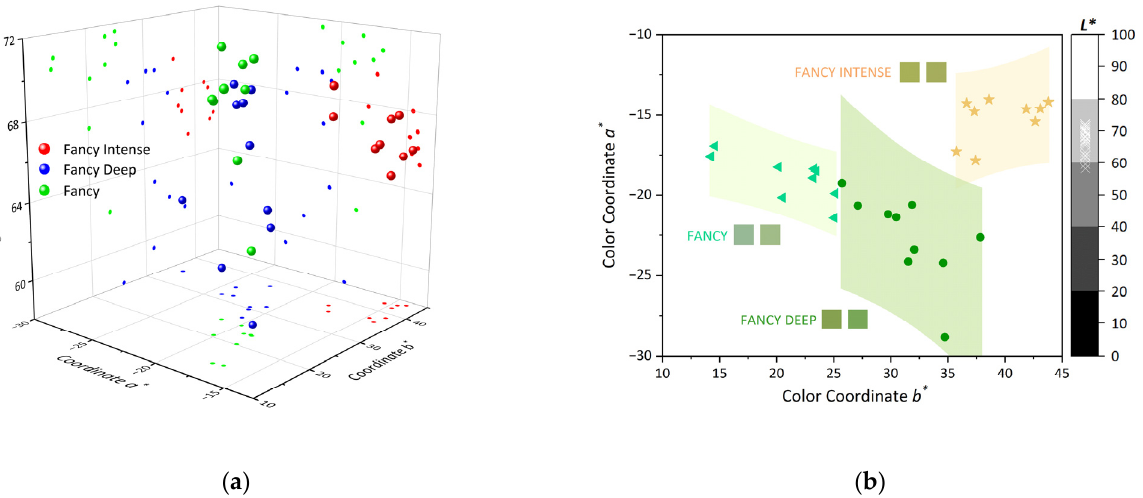
Figure 7. Color grading of yellow-green opal under D65 light source and N9.5 background. ( a ) Three groups of yellow-green opals in three-dimensional projection: Fancy Intense, Fancy Deep, and Fancy; ( b ) Color distribution of three groups of yellow-green opal samples. Table 3. Cluster analysis results of yellow-green opal color.